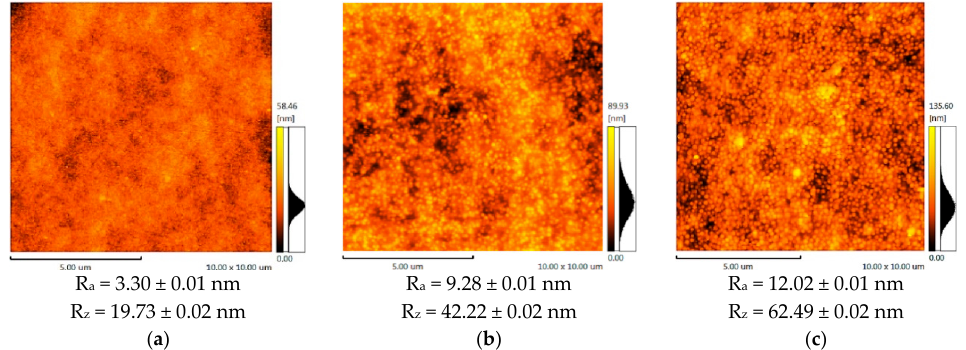
Figure 2. The AFM images and roughness parameters of: ( a ) the support UPM-20, ( b ) CS-PAN/UPM-20, ( c ) CS-PS/UPM-20.